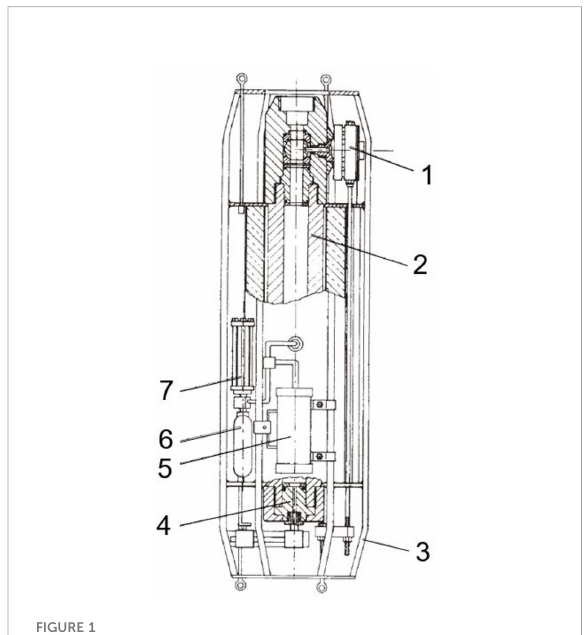
FIGURE 1 Schematic diagram of the recovery apparatus (1: Globe valve;2: recovery pressure vessel;3: frame;4: plug;5: depth recorder;6: hydraulic accumulator;7: pressure transducer housing) (adapted from Macdonald and Gilchrist, 1969).